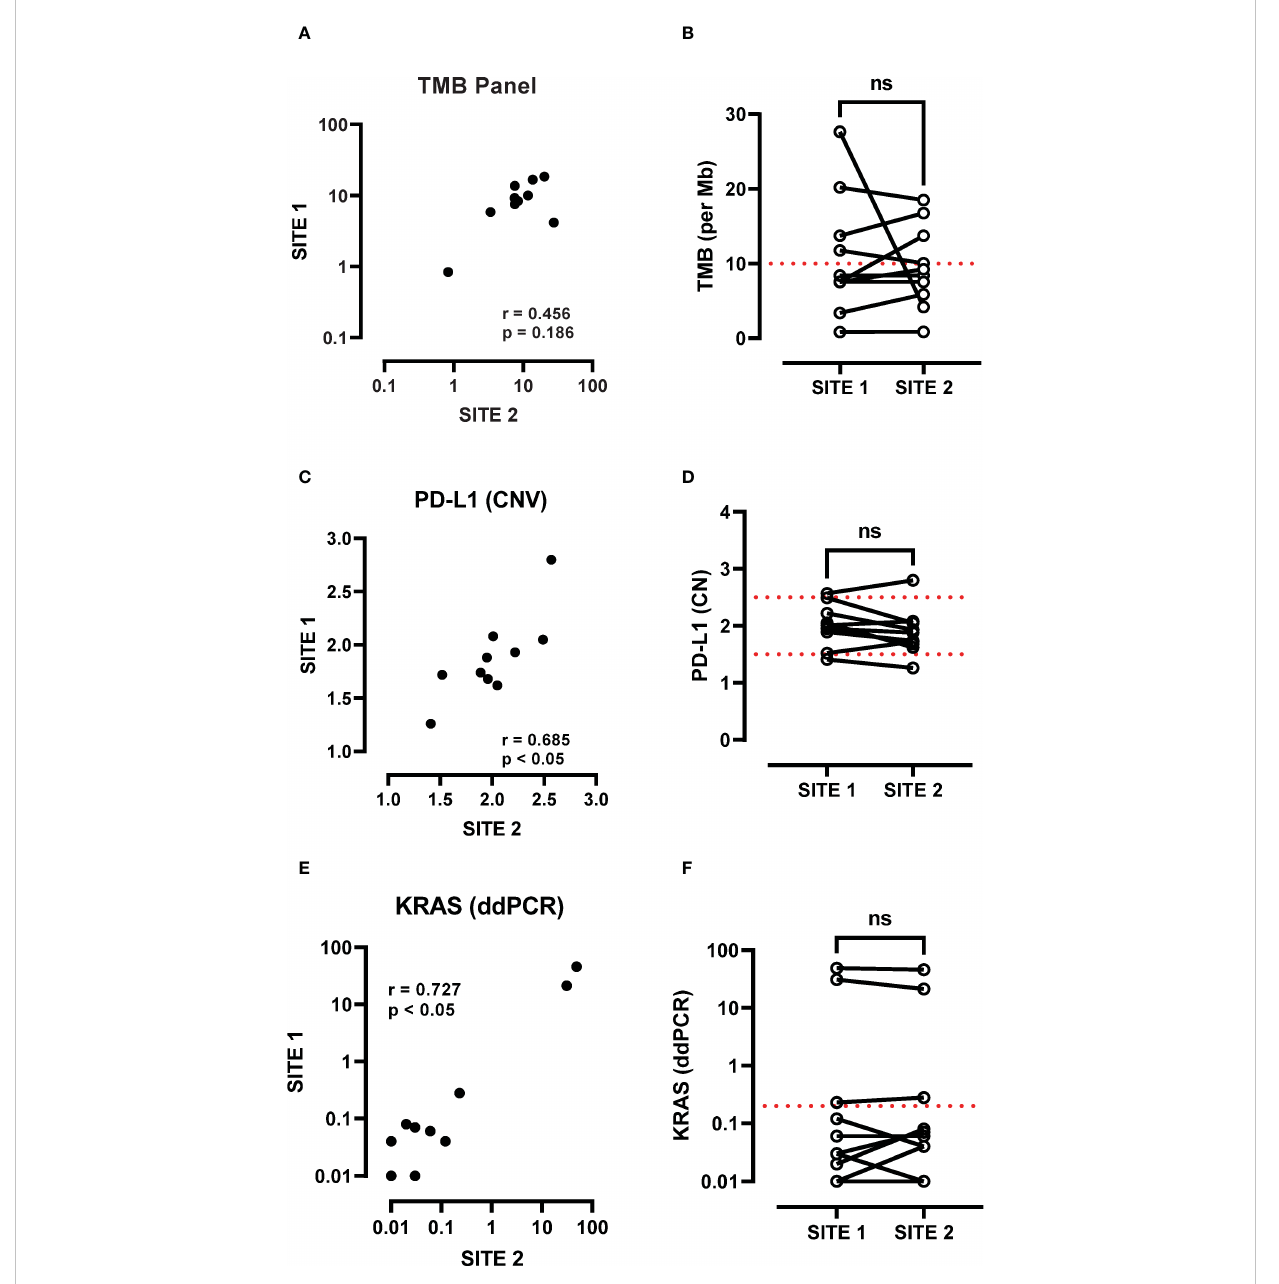
FIGURE 2 Assessment of TMB heterogeneity using the Oncomine panel. (A) TMB scores at the primary (site 1) and metastatic site (site 2) were compared by Spearman analysis and (B) paired analysis was performed between site 1 and site 2. (C) PD-L1 copy number at the primary (site 1) and metastatic site (site 2) were compared by Spearman analysis and (D) paired analysis was performed between site 1 and site 2. (E) KRAS G12/G13 mutations (G12A, G12C, G12D, G12R, G12S, G12V, G13D) were screened and a cut-off of 0.2% mutant allele frequency was used to determine presence of a KRAS mutation. KRAS mutation levels at the primary (site 1) and metastatic site (site 2) were compared by Spearman analysis and (F) paired analysis was performed between site 1 and site 2. ns, not signi fi